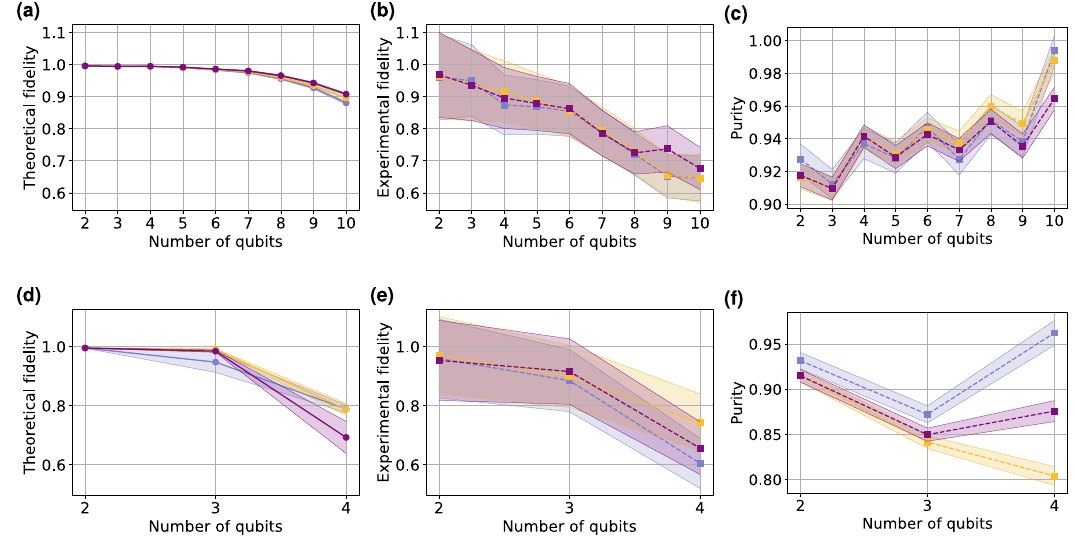
(cid:2) (cid:4) (cid:2) as a function of the number of qubits. a Theoretical 1